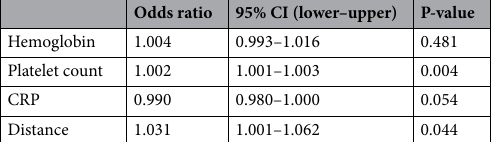
Table 3. Risk factors by multivariate logistic regression